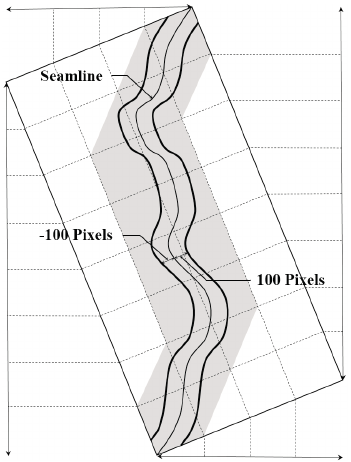
Figure 4. The subset procedure, each 100 pixels to the left and right of the center of each seamline.